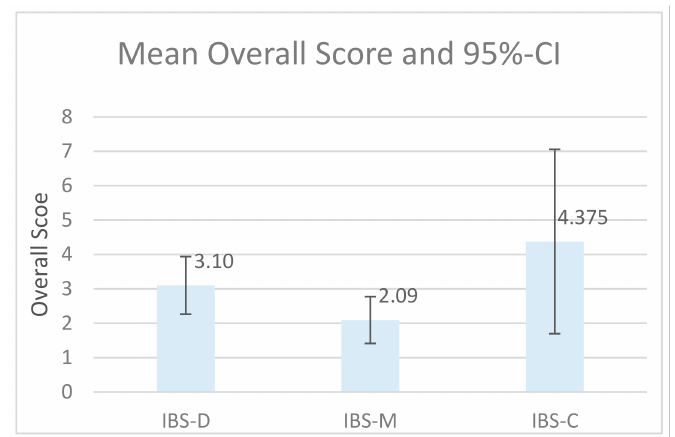
Figure 1. Reflective functioning (RF)-score for irritable bowel syndrome